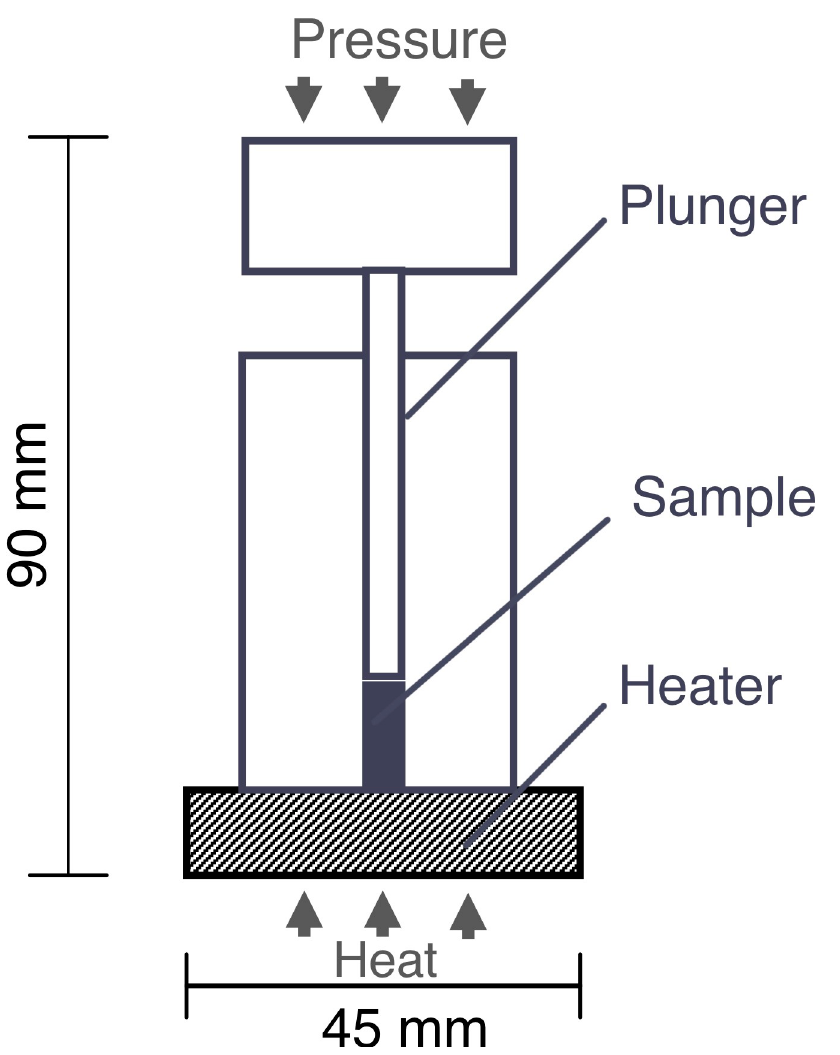
Fig 1. Schematic drawing of Thermal Rheological Analysis